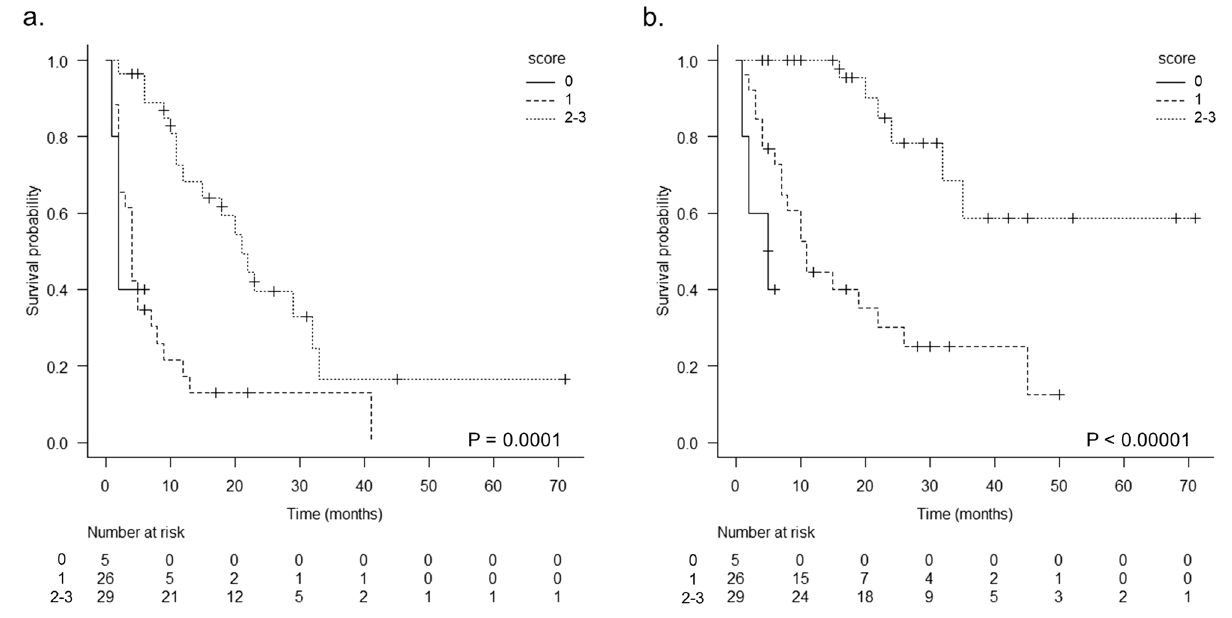
Figure 5. The results of the Kaplan–Meier analysis are presented. Relationship between immune cells score (total score of CD8-positive + 1, CD68-positive + 1 and CD4-negative + 1; Min 0, Max 3) and survival in groups with scores of 0–1 or 2–3 are analysed. ( a ) PFS comparison by immune cells score (log-rank P = 0.0001). ( b ) OS comparison by immune cells score (log-rank P < 0.00001).